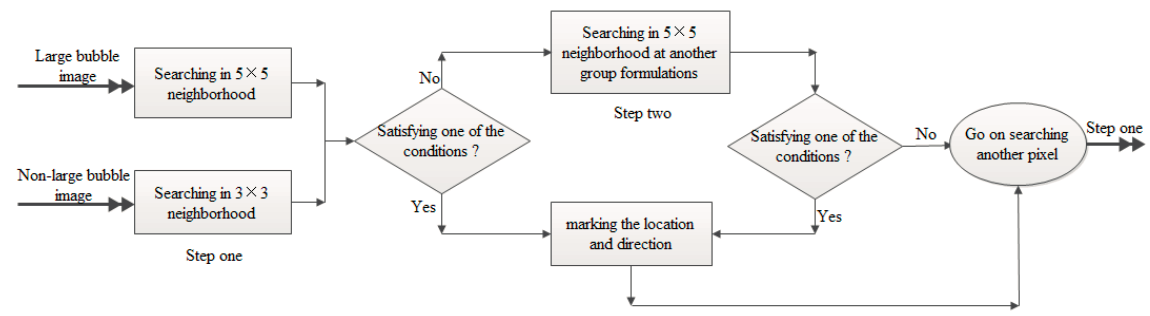
Figure 5. Algorithm workflow of the edge detection based on local gray value minima.